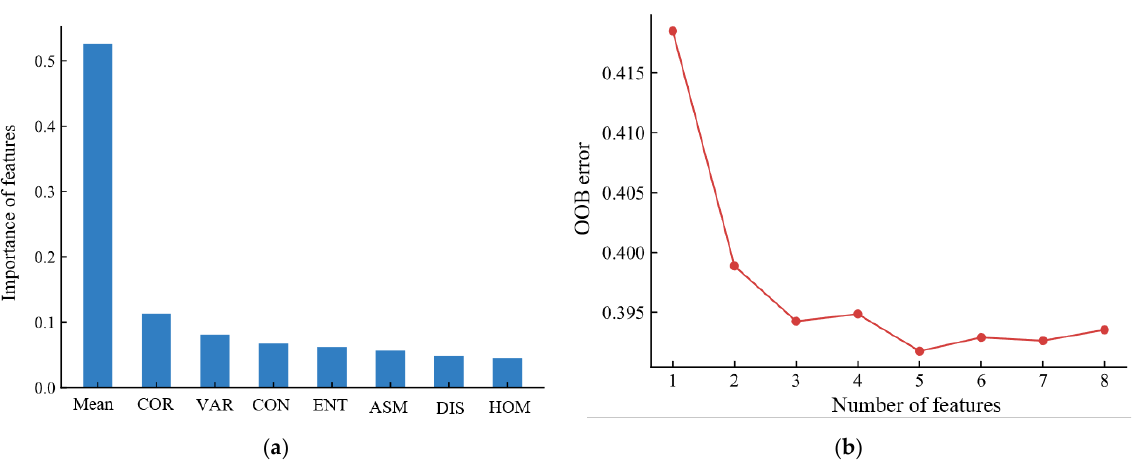
Figure 12. The importance ranking ( a ) and OOB error ( b ) of eight textural